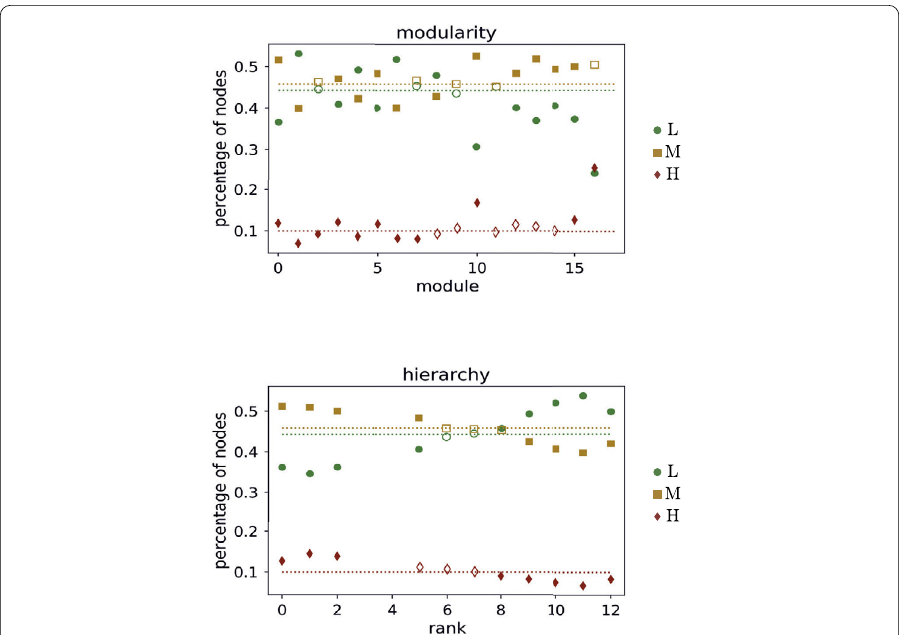
Figure 4 Distribution of ratings in the three partitions, modularity (top), hierarchy (bottom). The dashed lines are the unconditional (null) distribution of ratings among nodes in the entire sample. A full marker indicates that the over (above the dashed line) or under (below the dashed line) representation with respect to the null distribution is statistically significant in the hypergeometric test at 1% significance level with Bonferroni